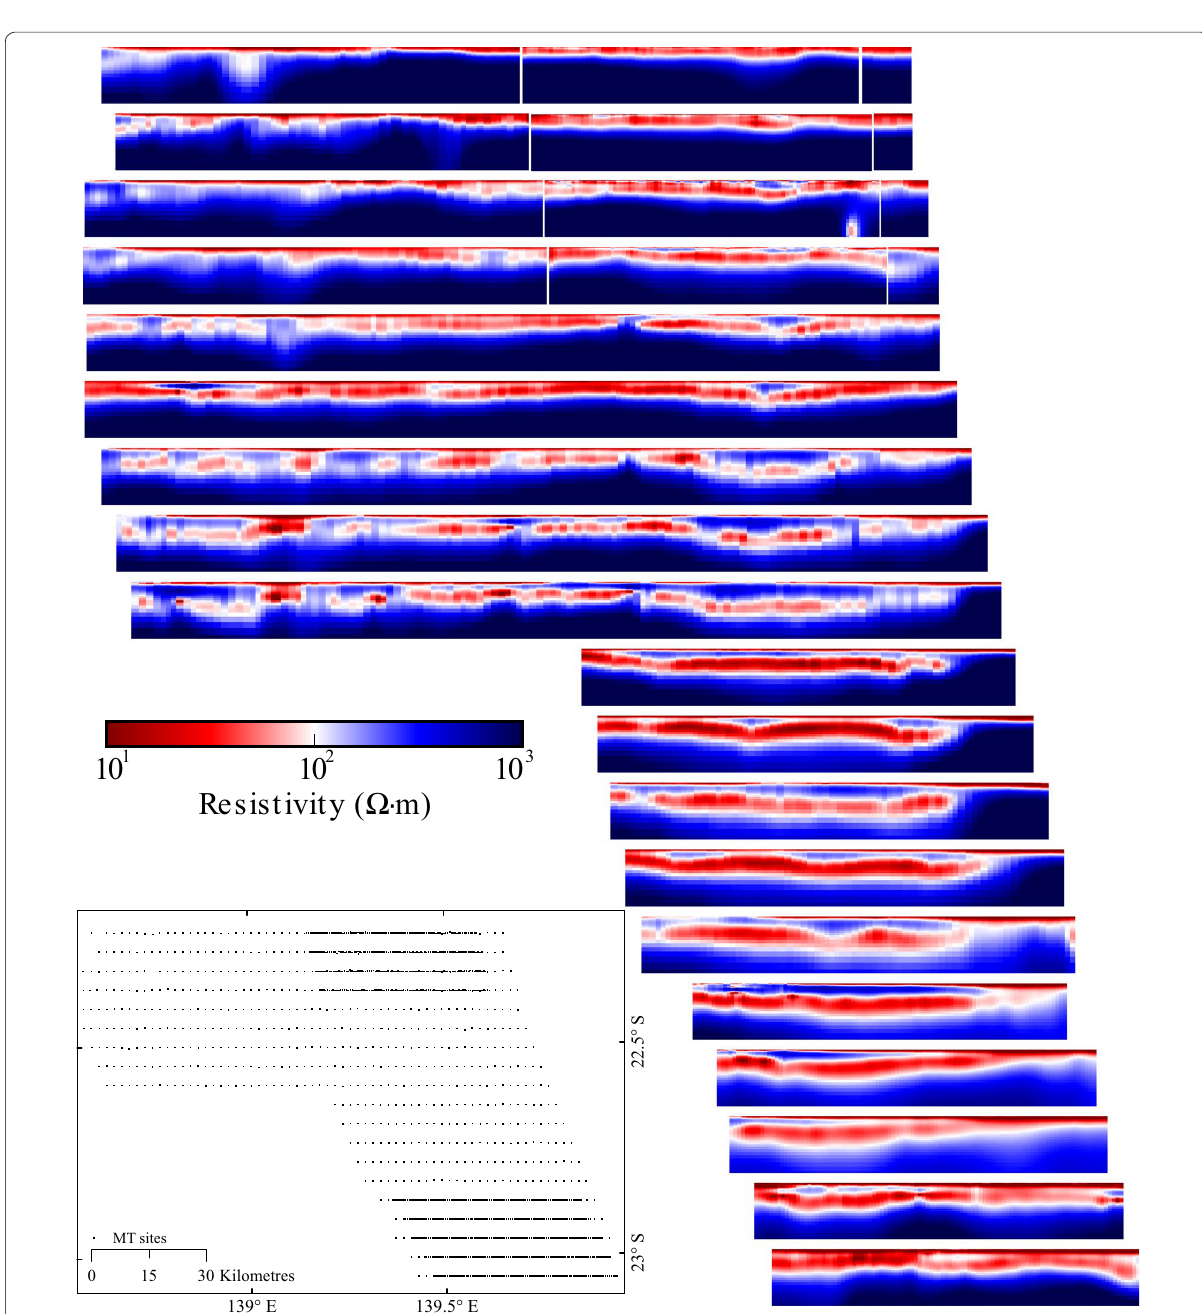
Fig. 8 Occam 2D inversion results for all profiles in study area. Where BBMT and AMT data are both present, only AMT inversion results are displayed. Location of all stations used for modelling shown in inset. Sections have a depth extent of 1500